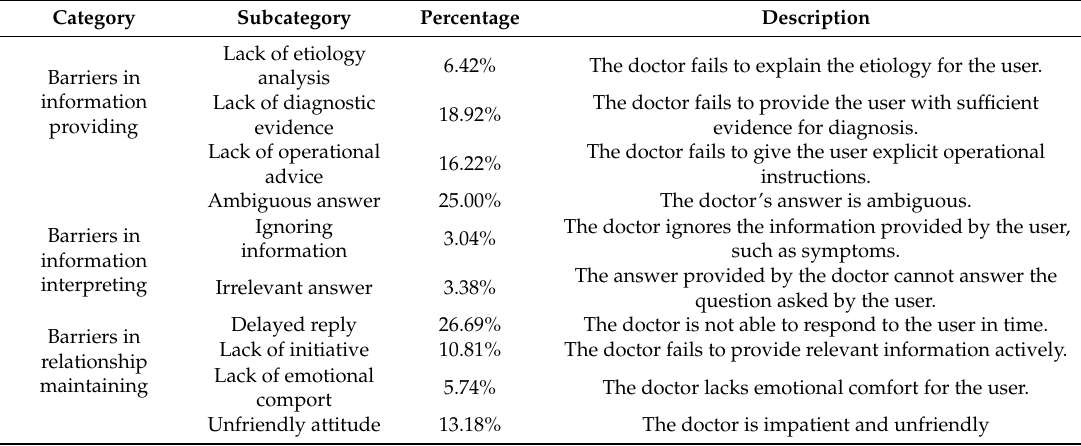
Table 2. Antecedents of poor DPR from the users’